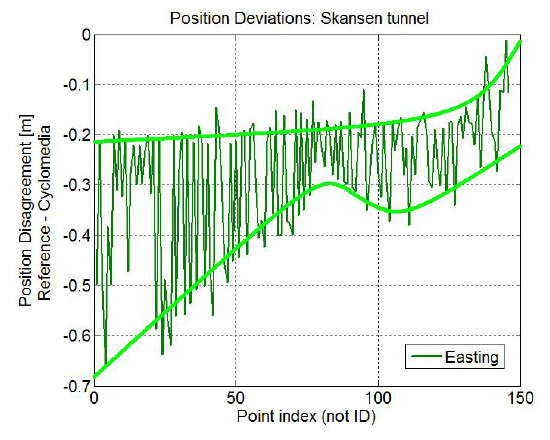
Figure 10: Object positioning results’ dependence on the trajectory used as observed along the East axis, Skansen tunnel result.